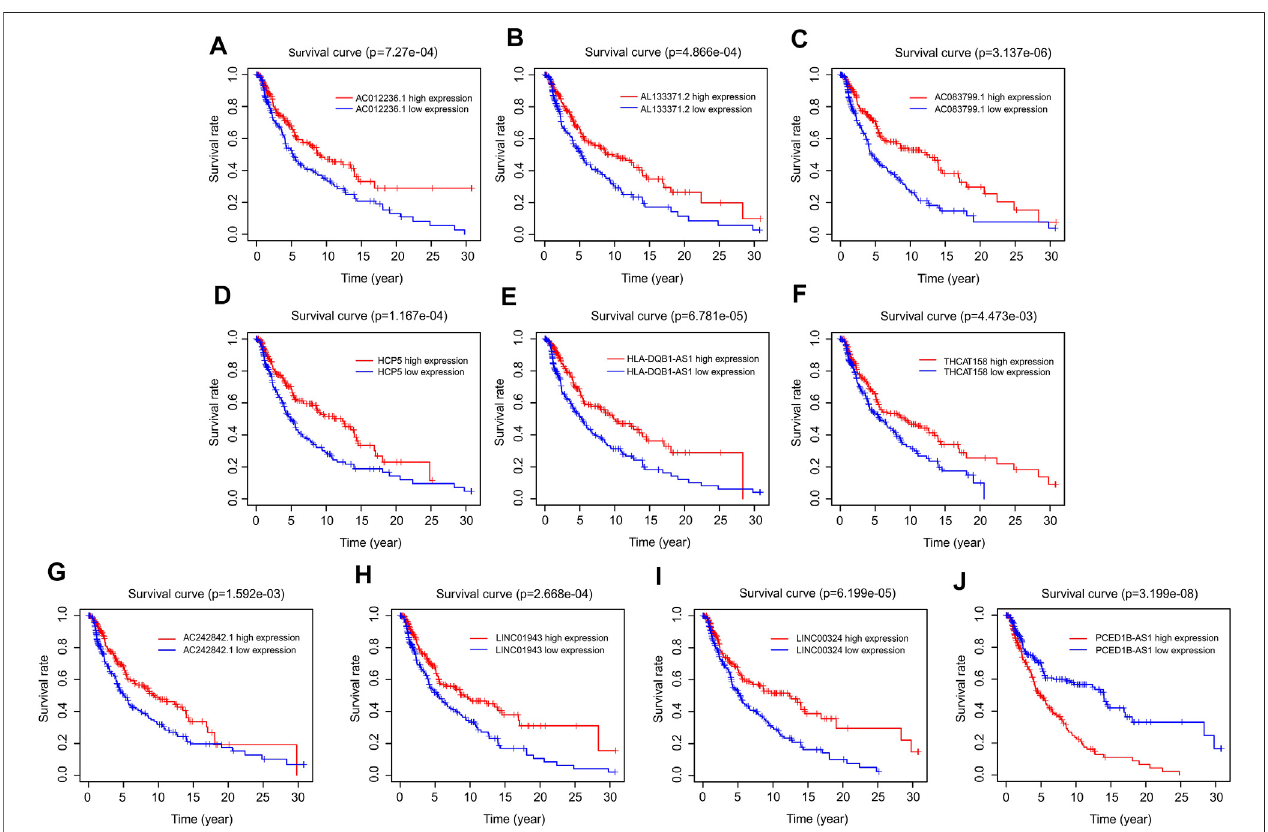
FIGURE4| Survivalcurveanalysisofautophagy-relatedlncRNAs.TheKaplan-Meiersurvivalcurveanalysisof (A) AC012236.1, (B) AL133371.2, (C) AC083799.1, (D) HCP5, (E) HLA-DQB1-AS1, (F) THCAT158, (G) AC242842.1, (H) LINC01943, (I) LINC00324, (J) PCED1B-AS1.